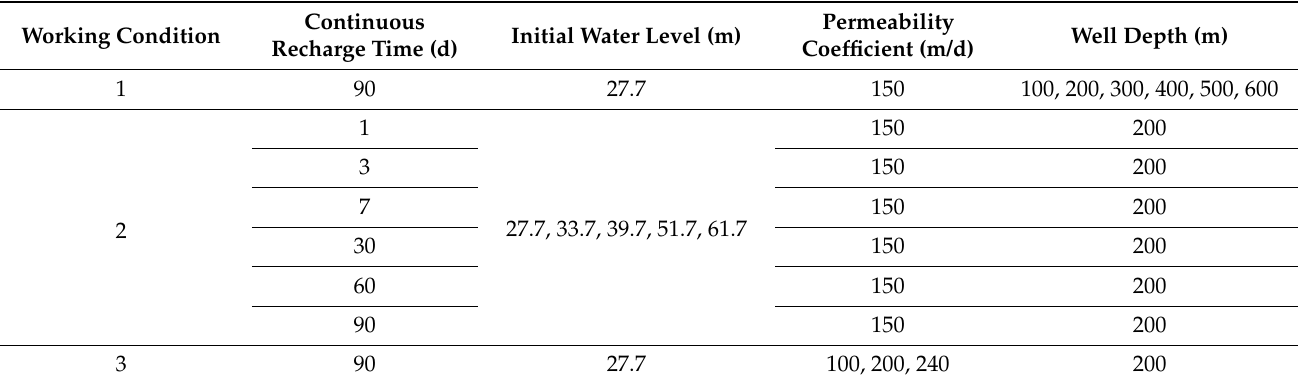
Table 5. Conditions of recharge capacity of different